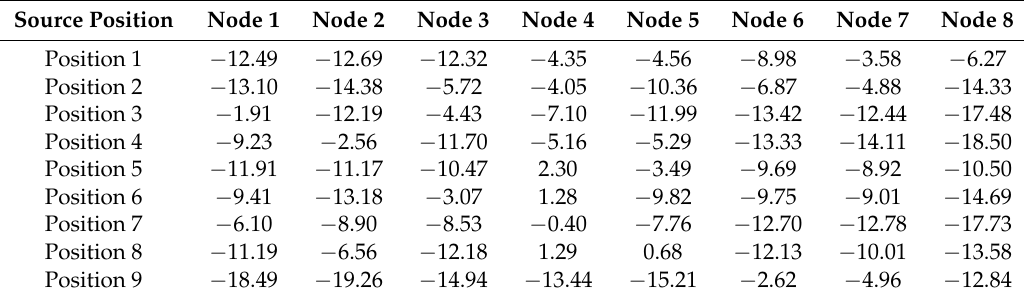
Table 1. Received signal power in d Bm